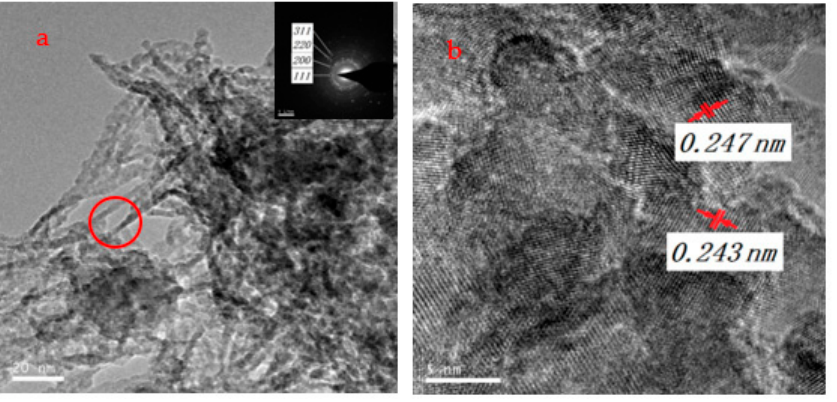
Figure 5. TEM photos of Cu 2 O nanochains and ( b ) is an enlarged view of the red zone of ( a